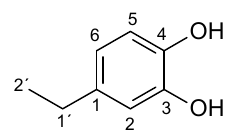
Figure A2. 4-ethylcatechol ( 2b ). 1 H NMR (399.87 MHz, DMSO- d 6 , 30 °C): 1.092 (3H, t, J = 7.6 Hz, H-2‘), 2.408 (2H, q, J = 7.6 Hz, H-1‘), 6.418 (1H, dd, J = 8.0, 2.1 Hz, H-6), 6.553 (1H, d, J = 2.1 Hz, H-2), 6.610 (1H, d, J = 8.0 Hz, H-5); 3,4-OH not detected. 13 C NMR (100.55 MHz, DMSO- d 6 , 30 °C): 15.85 (C-2 ′ ), 27.45 (C-1 ′ ), 115.11 (C-2), 115.39 (C-5), 118.15 (C-6), 134.57 (C-1), 142.99 (C-4), 144.95 (C-3).